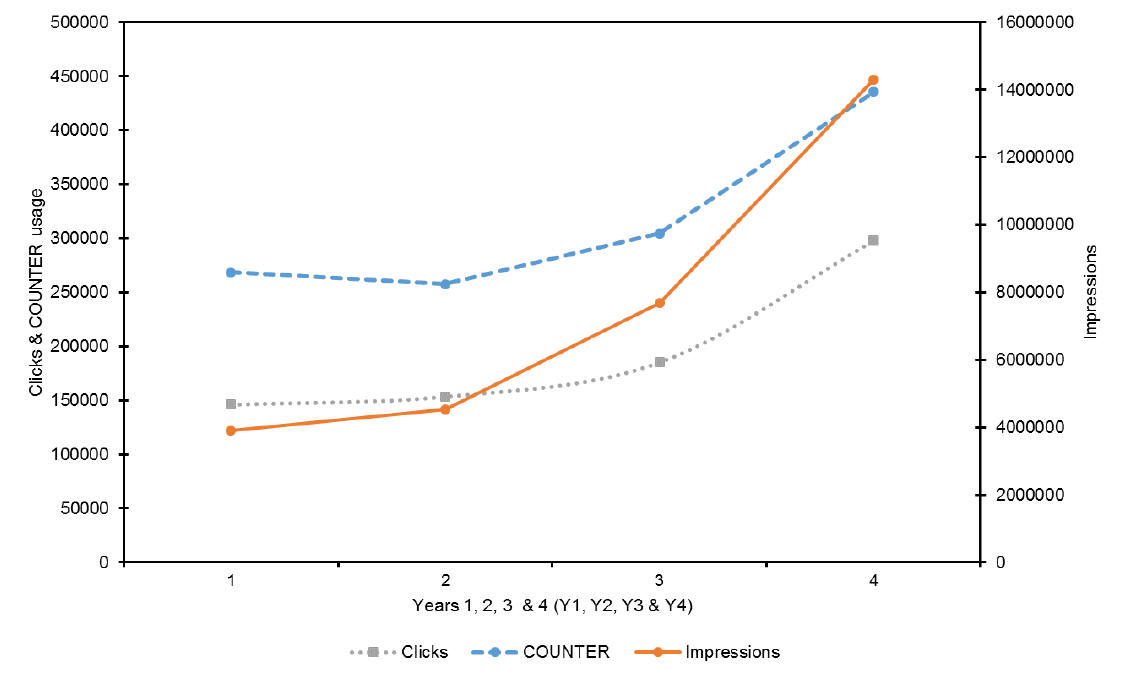
Figure 4. Charted data on observed clicks, impressions and COUNTER usage during Y1, Y2, Y3 and Y4. Table 4. Data table of Strathprints COUNTER usage during and Google clicks and impressions during Y1–Y4. Volume of full-text OA deposits and volume of combined full-text and embargoed